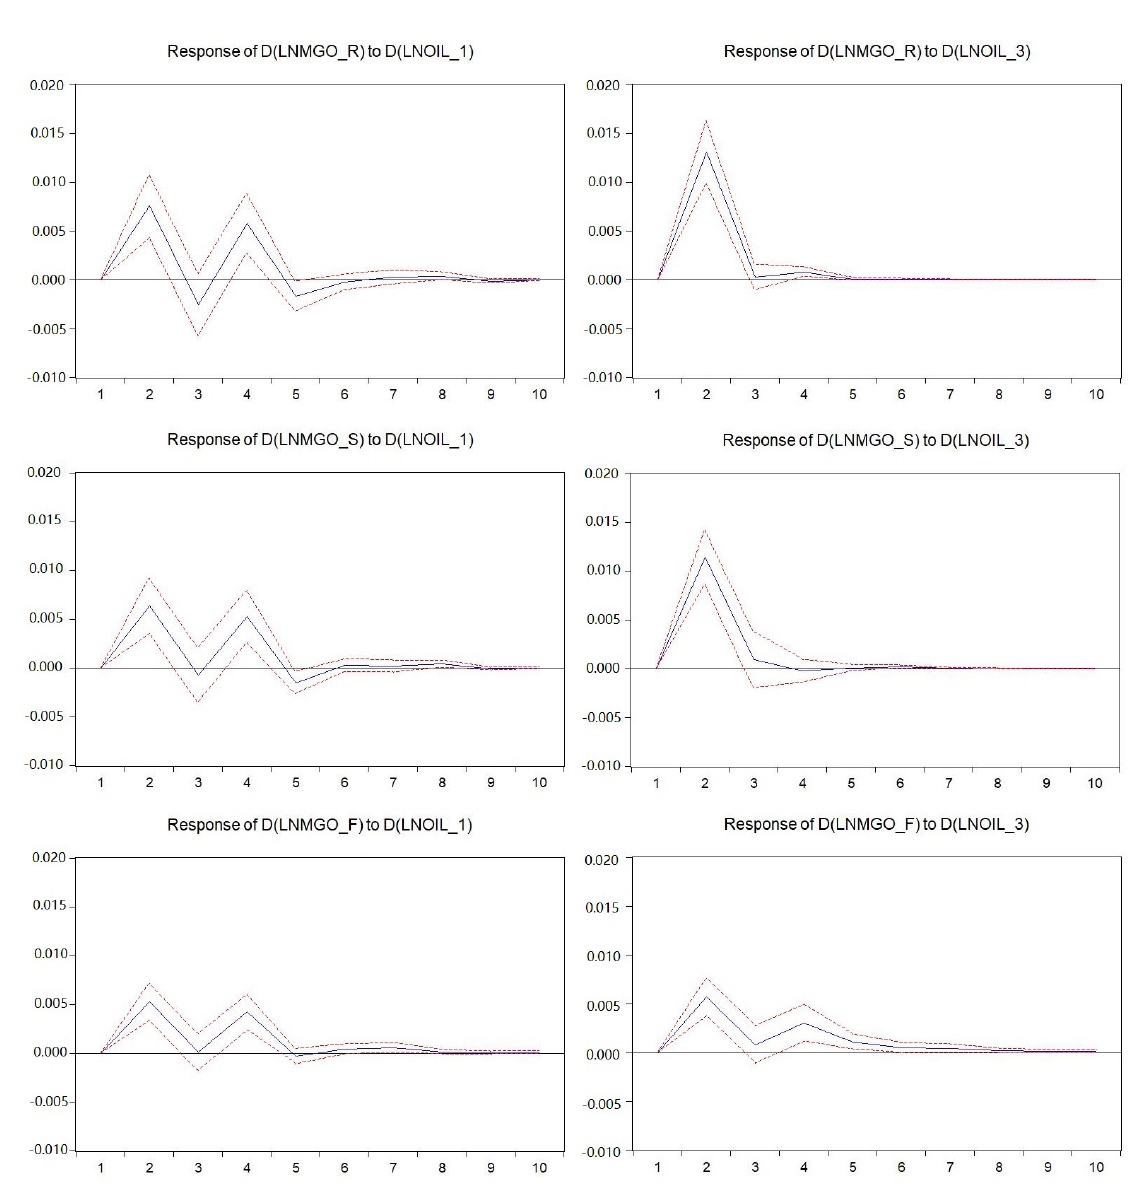
Figure 2. Response to Cholesky One S.D. (d.f. adjusted) Innovations ±2